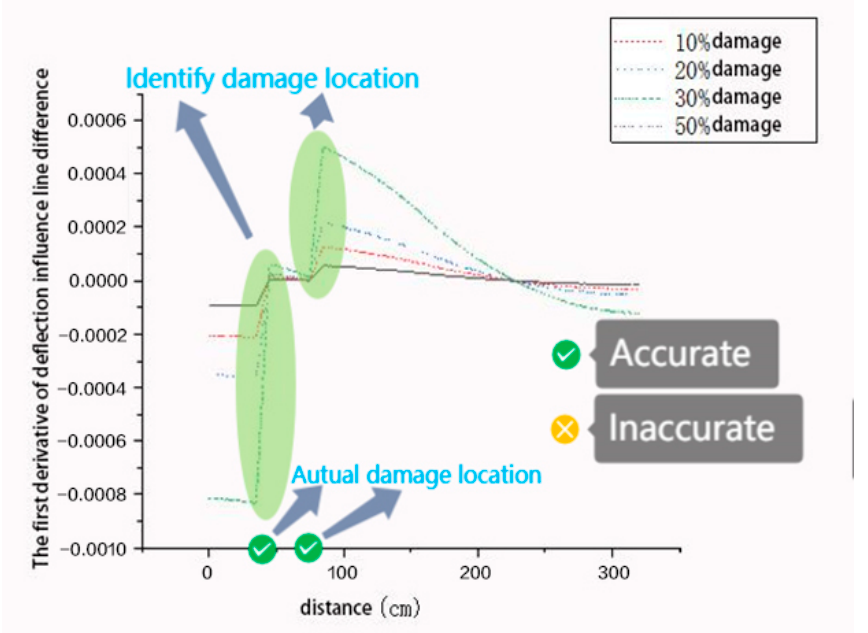
Figure 19. The 1st derivative of deflection influences line difference at 1/4 determining point of the 1st span under work condition 1 (2-5).